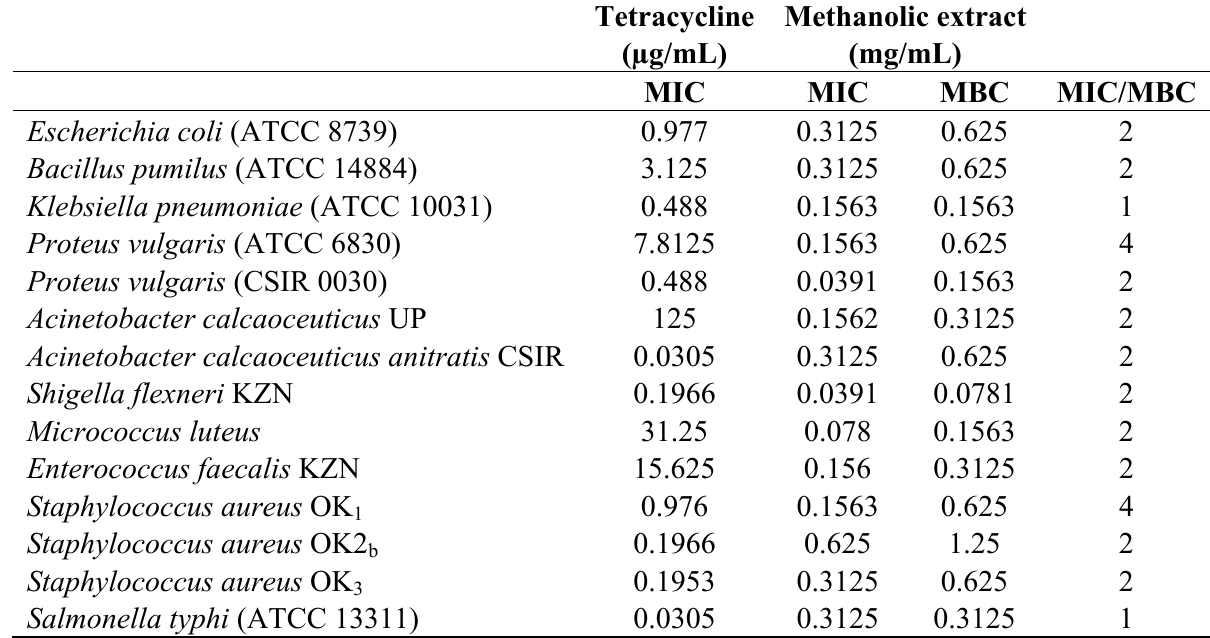
Table 1. Antibacterial activity of the methanolic extract of Acacia mearnsii De